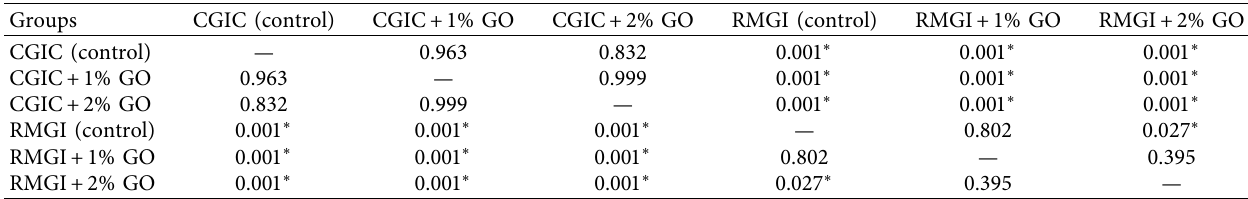
Figure 3: Mean fexural strength values. Te error bars represent the standard deviation of measurements for 10 samples ( n � 10). Table 3: P values between groups (Tukey